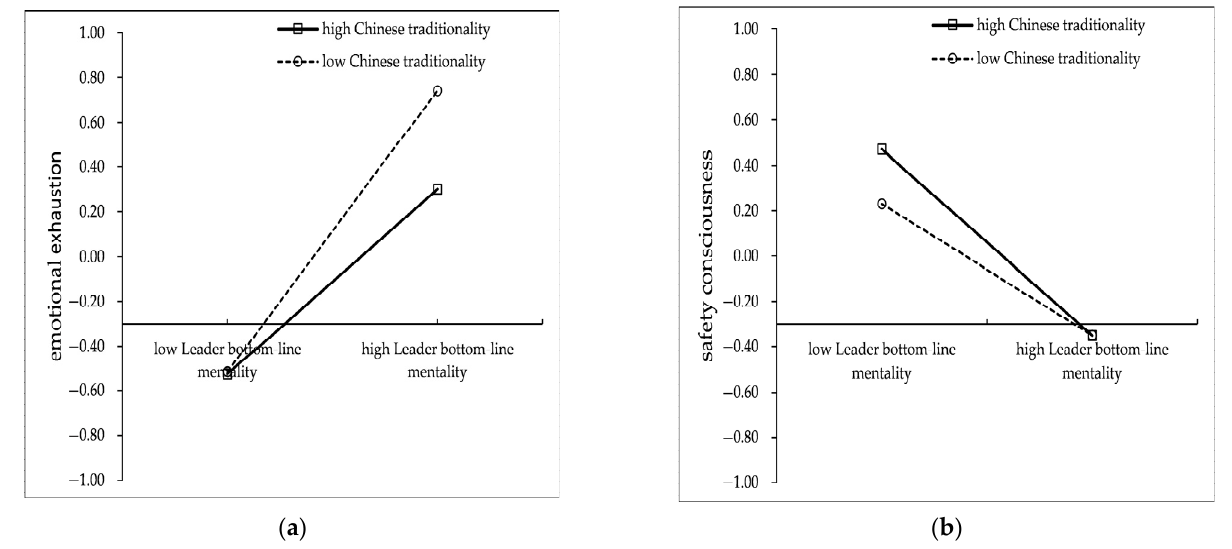
Figure 2. Moderating effect of Chinese traditionality. ( a ) The moderation of Chinese traditionality on emotional exhaustion. ( b ) The moderation of Chinese traditionality on safety consciousness. Table 7. Moderating effect and moderated mediating effect results (N = 422).